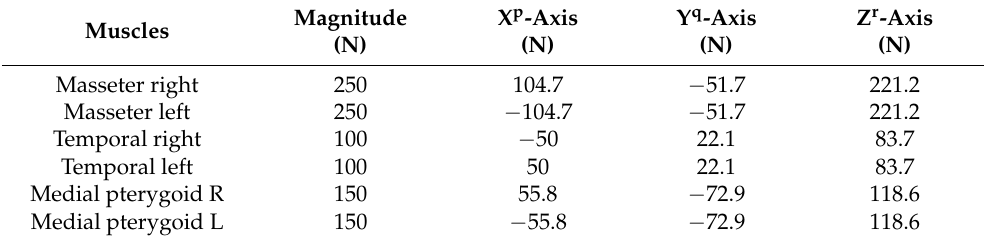
Table 2. Magnitude and direction of the muscle forces in the present work [21].